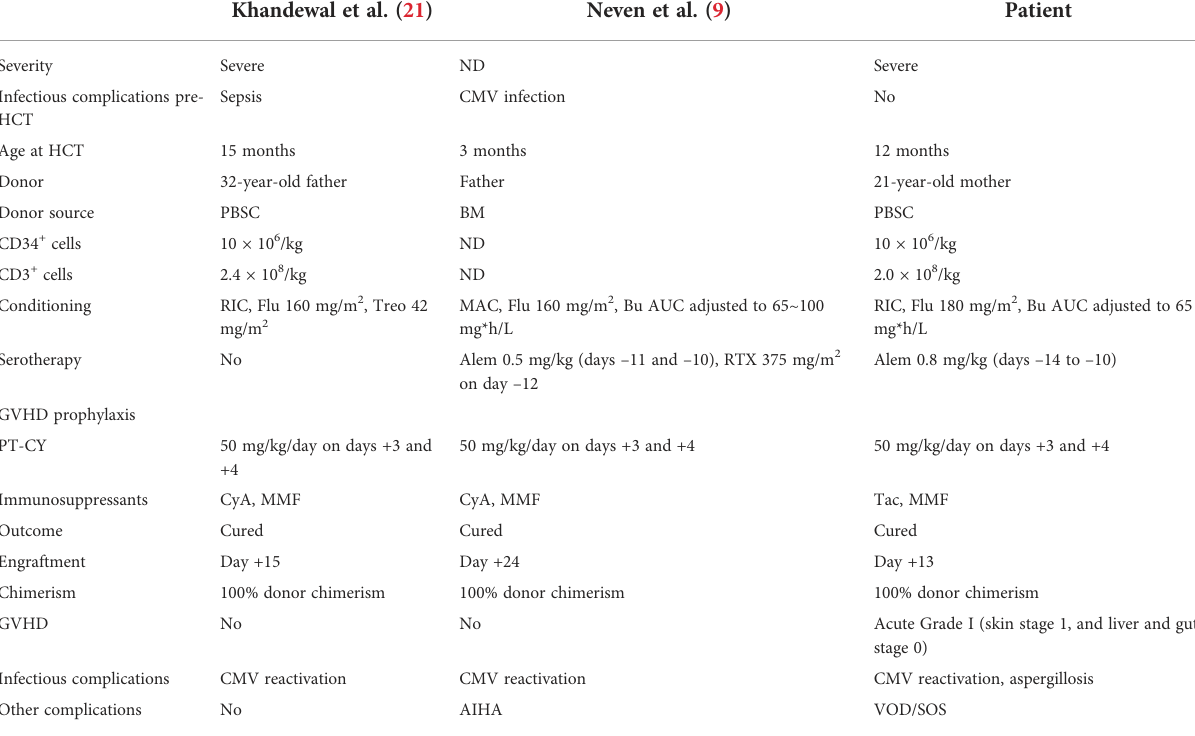
TABLE 1 Summary of reported HLA-haploidentical HCT with PT-CY for LAD-I